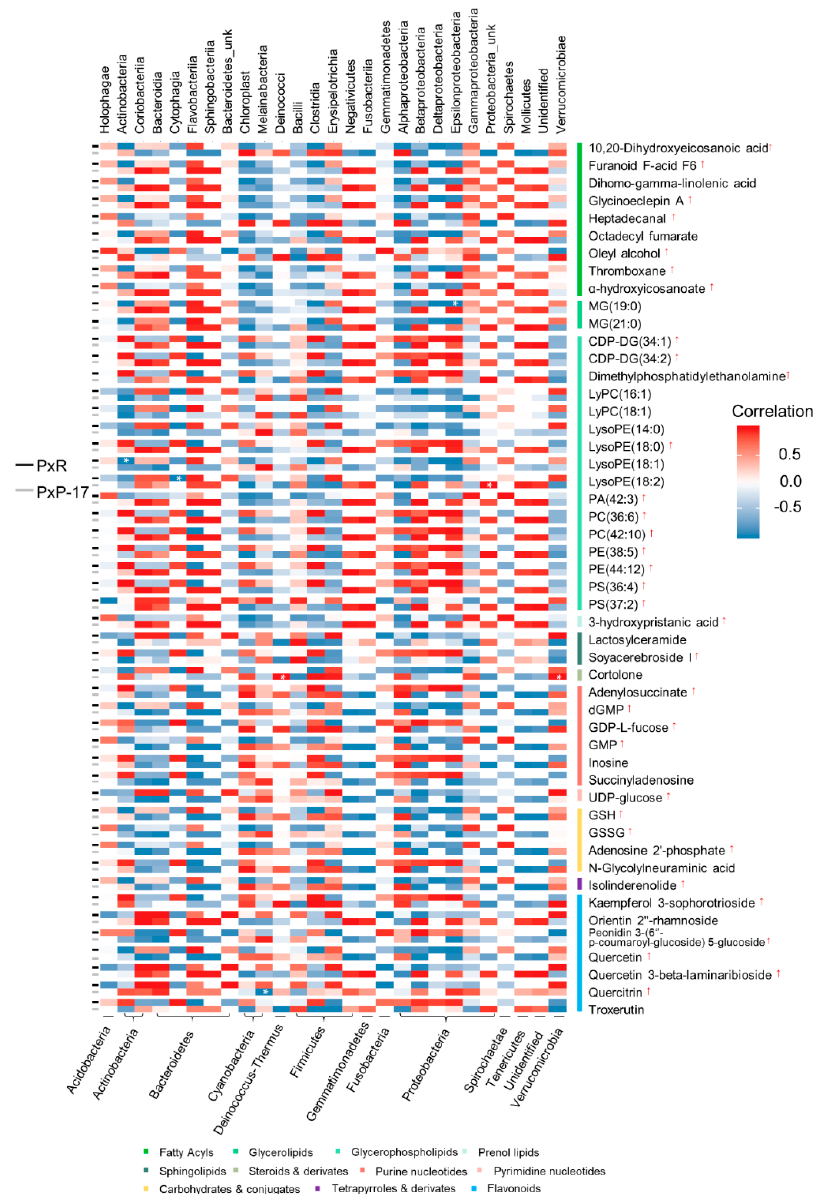
Figure 6. Relationships between gut bacteria classes and the top 50 most abundant metabolites in PxP-17 and PxR. Each bacterial class in the two populations was correlated with each metabolite. Asterisks represent statistical significance ( p < 0.05). Red arrows indicate that the metabolite abundance was higher in PxP-17 than in PxR. PxR: P. xylostella feeding on radish; PxP-17: the 17th generation of P. xylostella feeding on peas after host shift from radish. MG: monoacylglycerols; CDP-DG: cytidine diphosphate diacylglycerol; PA: phosphatidic acid; PC: phosphatidylcholine; PE: phosphatidylethanolamine; PS: phosphatidylserine; LyPC: lysophosphatidylcholine; LysoPE: